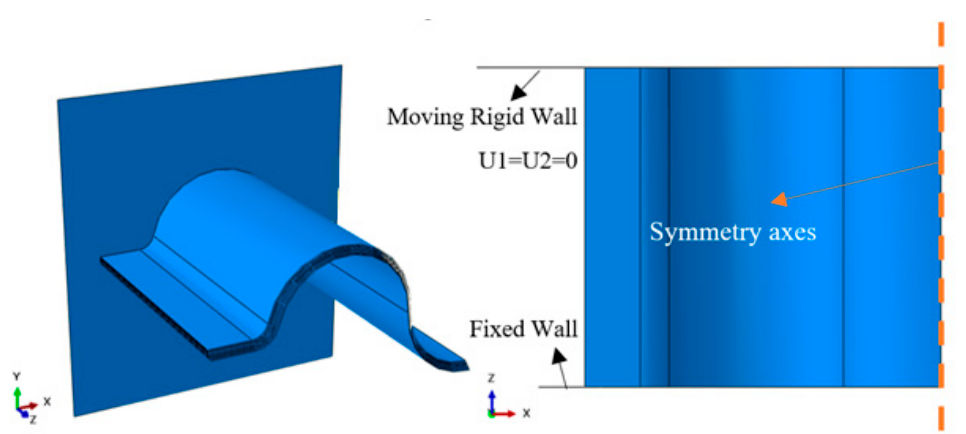
Figure 5. Abaqus/CAE half model of the sinusoidal structure with 3 curvatures: isometric view ( left ) and front view ( right ).